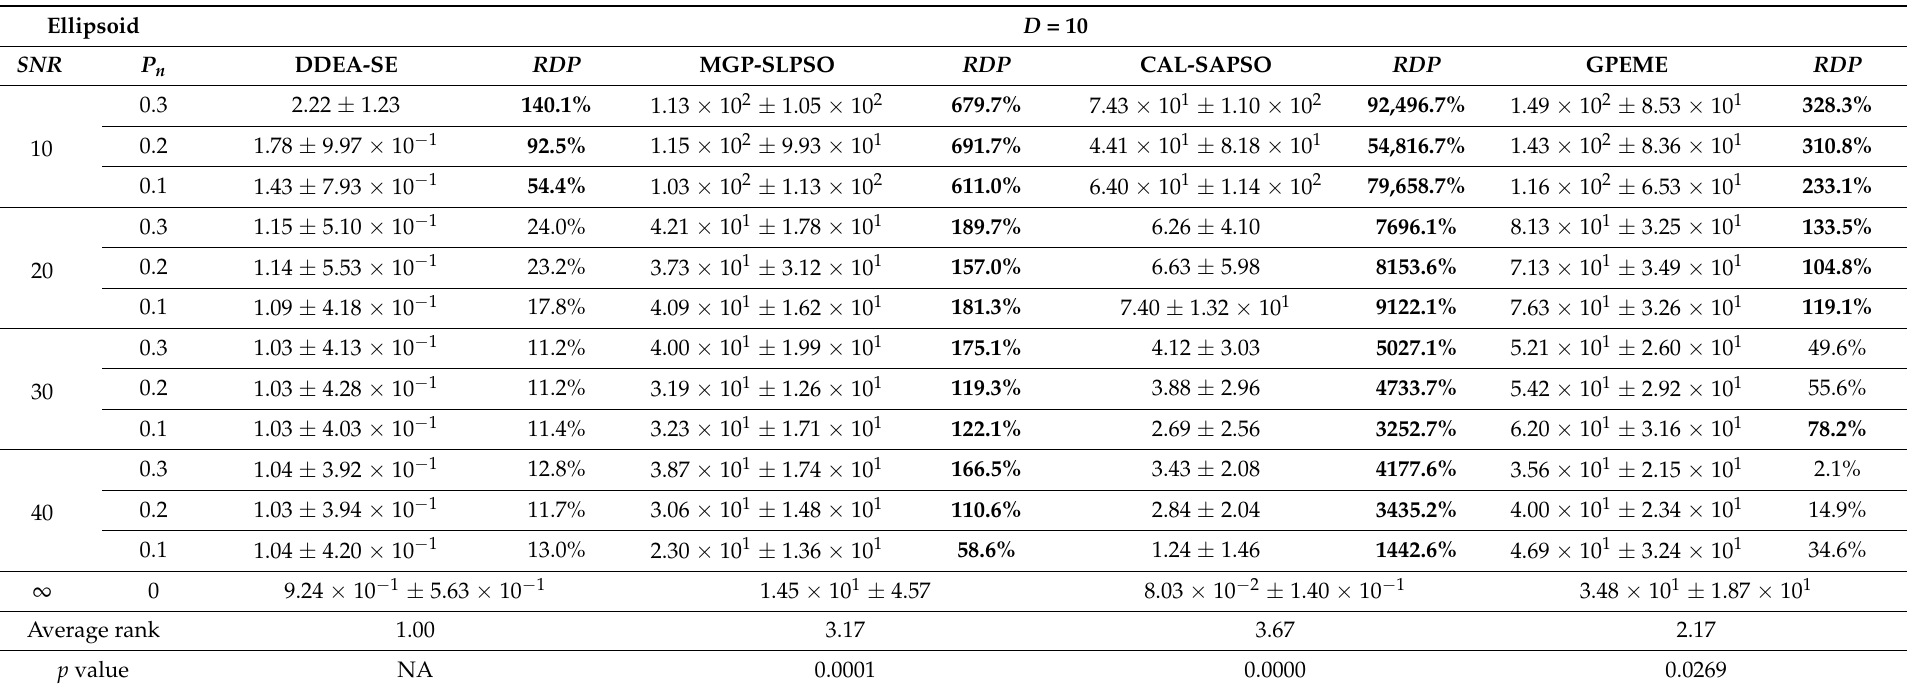
Table A1. Experimental results (with standard deviation) and relative deterioration percent ( RDP ) of DDEAs on 10-dimensional ellipsoid problems. The RDP of results that significantly differ from the results obtained in non-noisy environment are shown in bold. The average rank and p value are the results of the Friedman’s test with a significance level of 0.05.